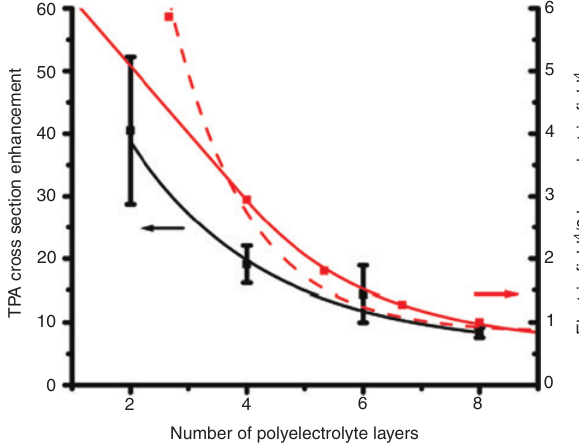
Figure 23: Two-photon absorption cross-section enhancement (left axis) and simulated surface plasmon polariton electric field (right axis) versus distance from the gold nanorod surface, in terms of polyelectrolyte layers. The black line is an exponential fit to the data. The red lines are based on calculations of the electric field; the red dashed line is a single exponential fit including the two- layer data, while the red solid line does not include two-layer data. Adapted with permission from Ref. [131]. Copyright (2015) American Chemical